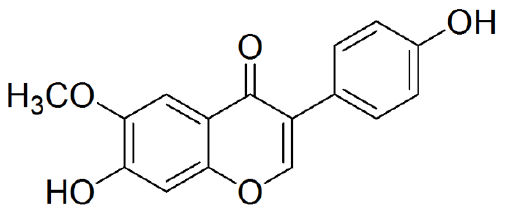
Figure 1. The structure of